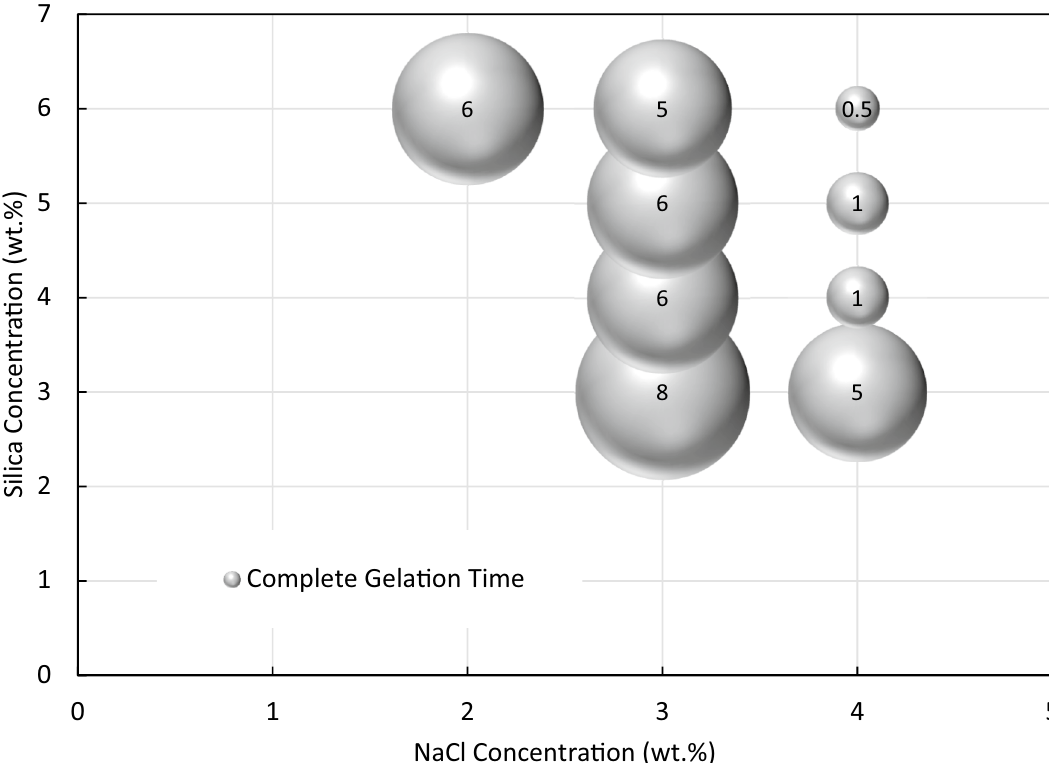
Figure 5. Bubble plot of gelation time (0.5–8.0 h) for different concentrations of silica (3–6 wt%) and NaCl (2–4 wt%) in DIW as gellants. The diagram represents the time required for a complete single-phase solid gelation obtained visually via bottle